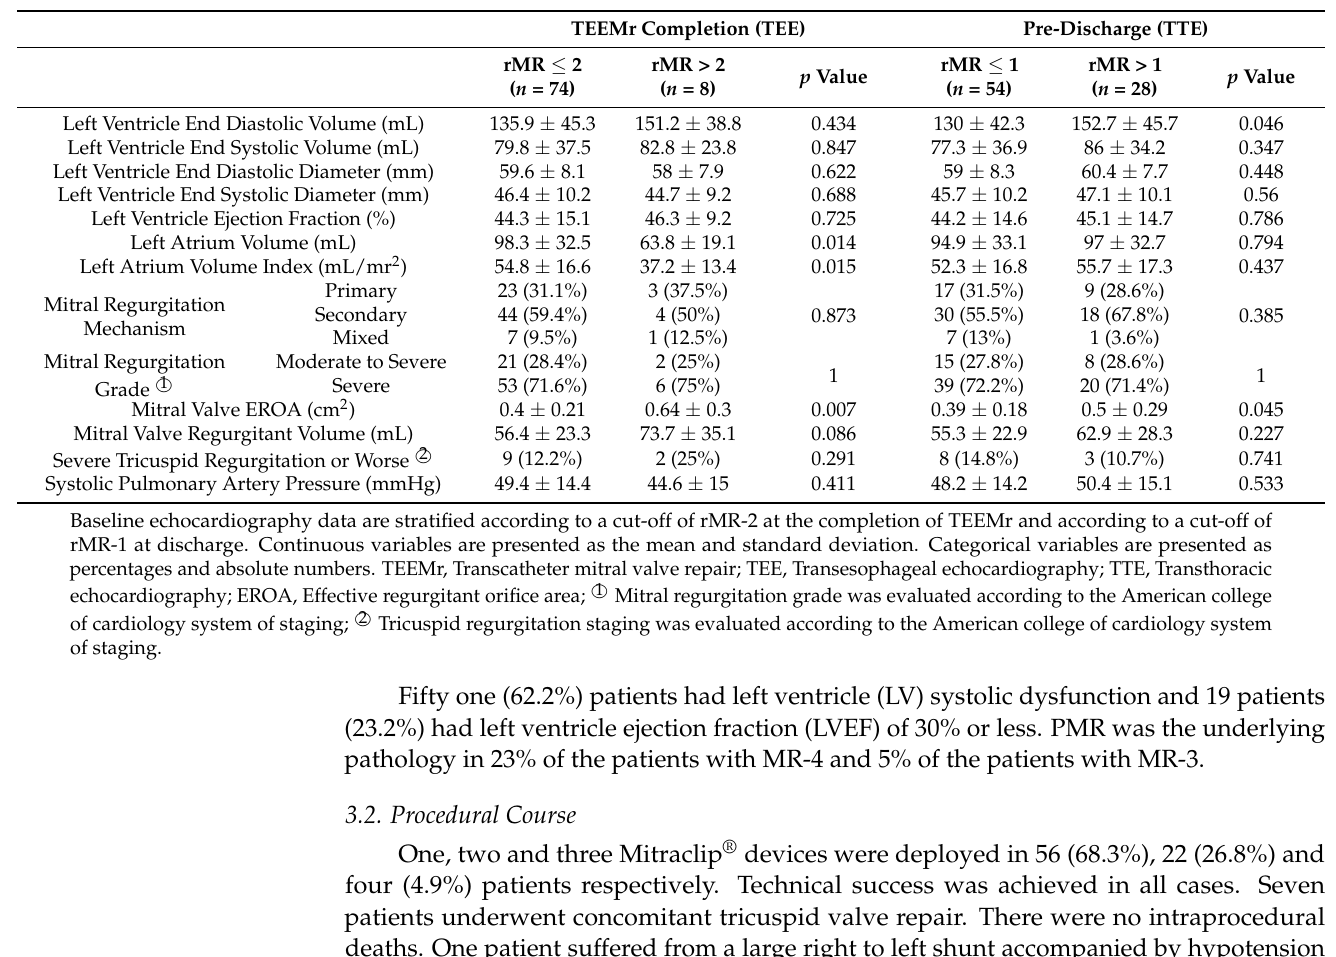
Table 2. Baseline echocardiography parameters taken prior to